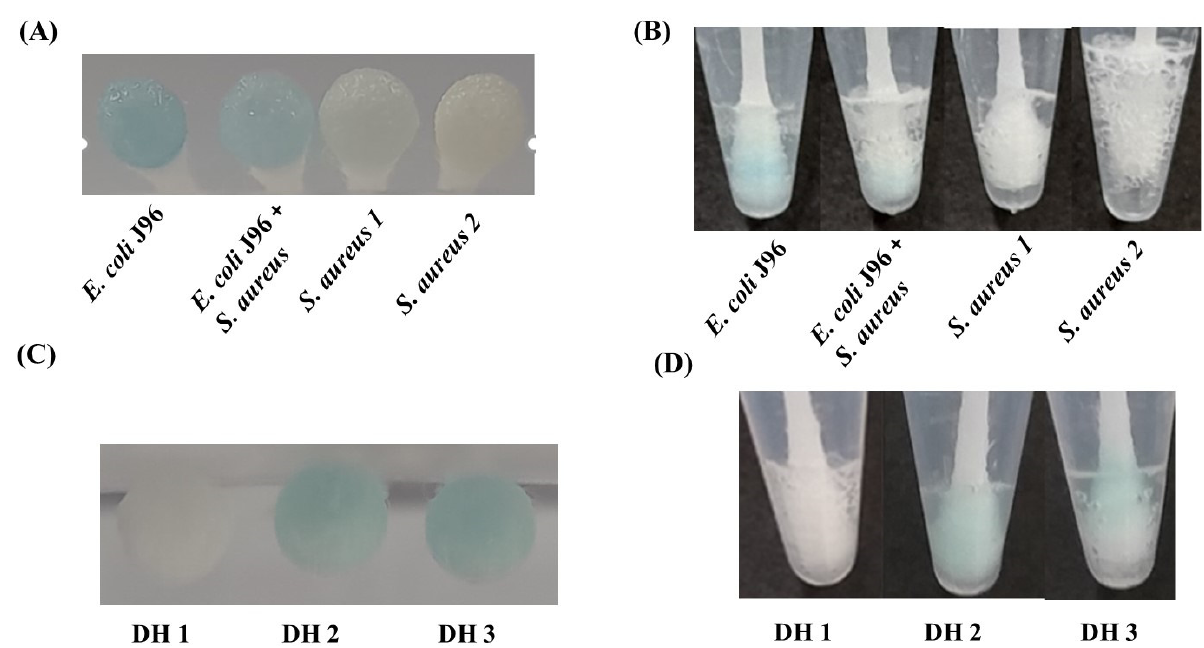
Figure 7. Detection of bacteria from door handles. ( A ) Photograph of the cotton swabs obtained after sampling bacteria from door handles smeared with the bacterial samples, including E. coli J96 (2.7 × 10 5 cells), the mixture of E. coli J96 (~2.7 × 10 5 cells) and S. aureus (~8.5 × 10 7 cells), and two S. aureus samples with different cell numbers (~8.5 × 10 5 cells ( S. aureus 1) and ~8.5 × 10 7 cells ( S. aureus 2)), followed by dipping into a reagent (50 µL) containing H 2 O 2 (11.2 mM) and TMB (1.25 mM) at pH 3. ( B ) Photograph of the cotton swabs from Panel A, obtained after further reaction with a reagent containing H 2 O 2 (180 mM, 0.1 mL) at pH 3. ( C ) Photograph of the swabs used to collect bacteria from the door handles from the restroom, obtained after reaction with the reagent (50 µL) containing TMB (1.25 mM) and H 2 O 2 (~11.2 mM). ( D ) Photograph of the cotton swabs from Panel C, obtained after further reaction with H 2 O 2 (180 mM, 0.1 mL) at pH 3.